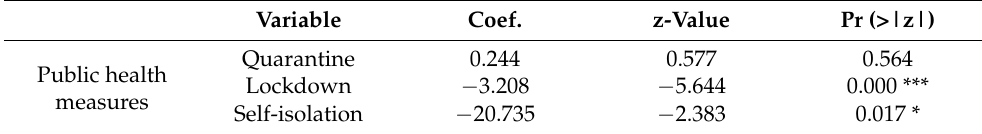
Table 9. Random effect partial results of states ranking 31 to 50.